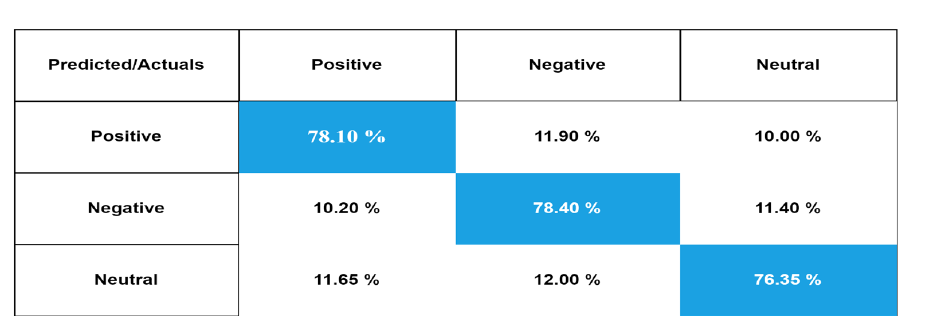
Figure 6. Confusion matrix of our proposed model using our proposed UCSA-21